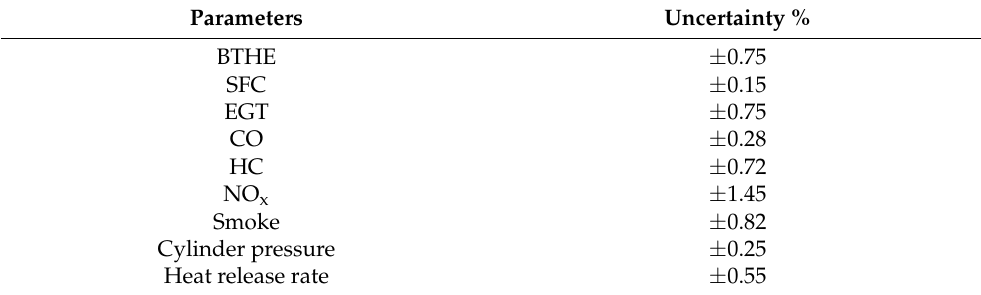
Table 5. Variable metrics’